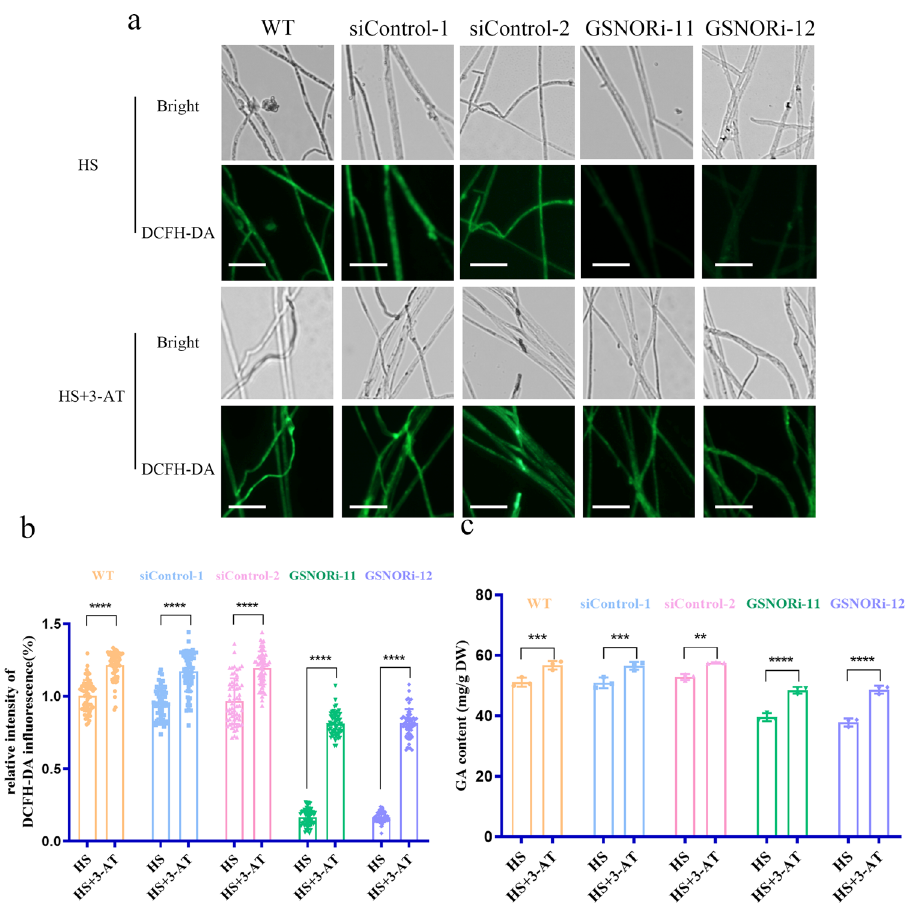
Fig. 3 ROS and GA content in the GSNOR-silenced strains treatment with 3-AT under HS conditions. a Coverslips were placed on the bottom Petri dishes; after the WT and GSNOR-silenced strains cultured on mycelium grew onto the coverslips, the fungal mycelium was transferred onto a PDA plate with 3-amino-1,2,4-triazole (3-AT) for 30 min, then exposed to 42 °C for 20 min. ROS content was measured by staining with DCFH-DA in the WT and GSNOR-silenced strains untreated or treated with 3-AT. Scale bar, 100 μ m. b ROS levels in the WT and GSNOR-silenced strains treated with 3-AT. c The WT and GSNORi strains were grown for 5 days in PDA liquid cultures with shaking and then treated with 3-AT for 30 min. The strains were exposed to 42 °C for 12 h and shifted to 28 °C until the 7th day in stationary. The GA content in the GSNOR-silenced strains was untreated or treated with 3-AT in the heat-stressed strains. Data are presented as the mean ± SD of data from three independent experiments (** P < 0.01, *** P < 0.001; **** P < 0.0001 by two-way